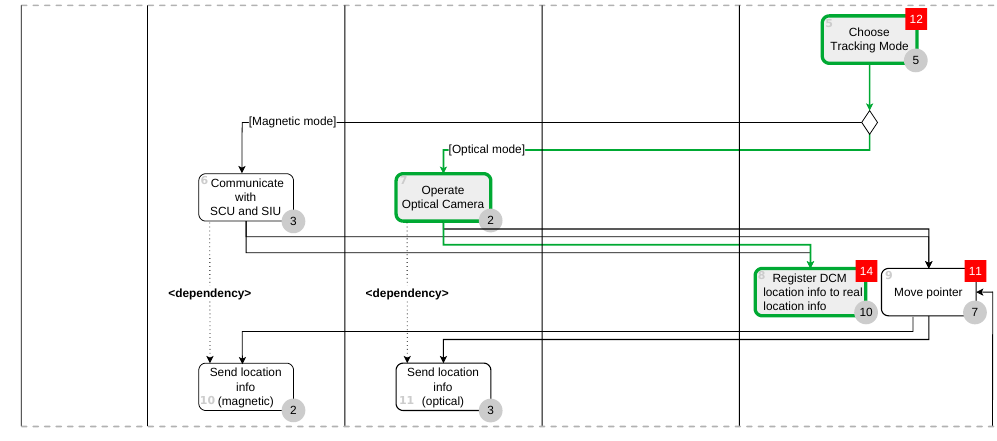
Figure 15. Final procedure 2. Table 6. Usability testing cost comparison.